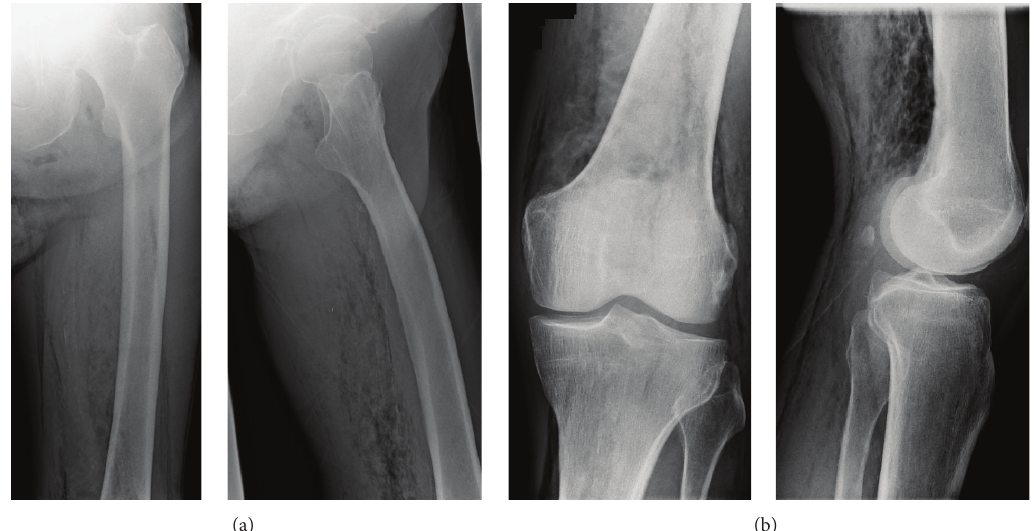
Figure 1: X ray of the left proximal femur and knee with demonstration of free air.